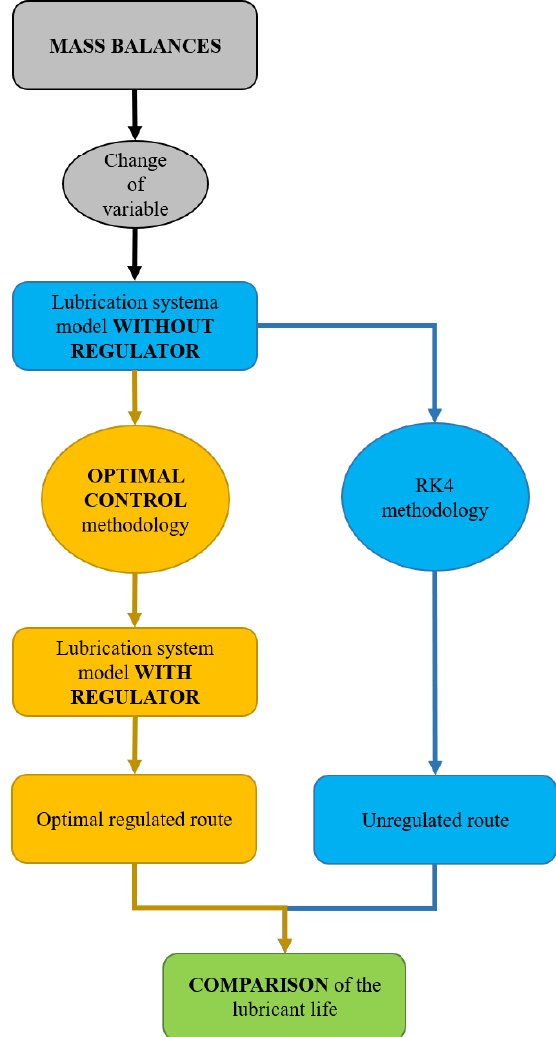
Figure 3. Scheme of the methodology to find out the optimal regulated route and to compare it versus the unregulated route.